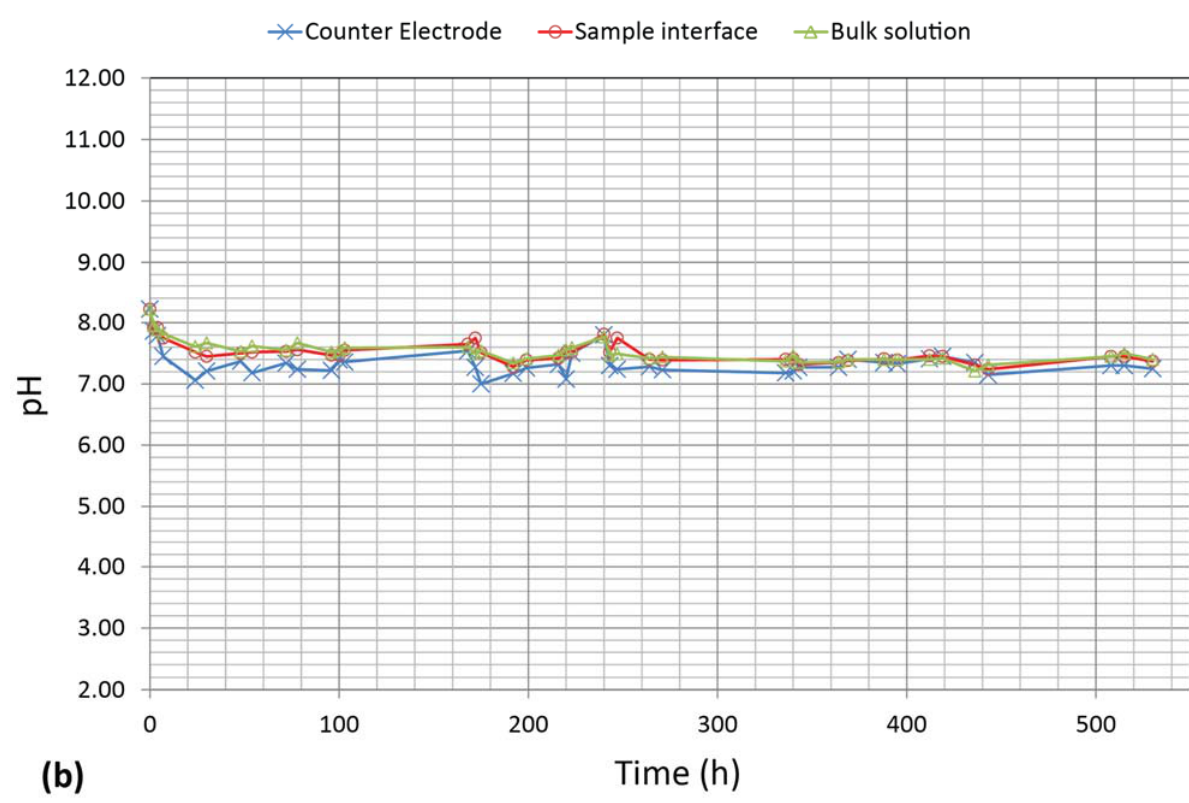
Figure 6. pH plots for ( a ) 3.5% w/v NaCl and ( b ) ASTM D1141 synthetic